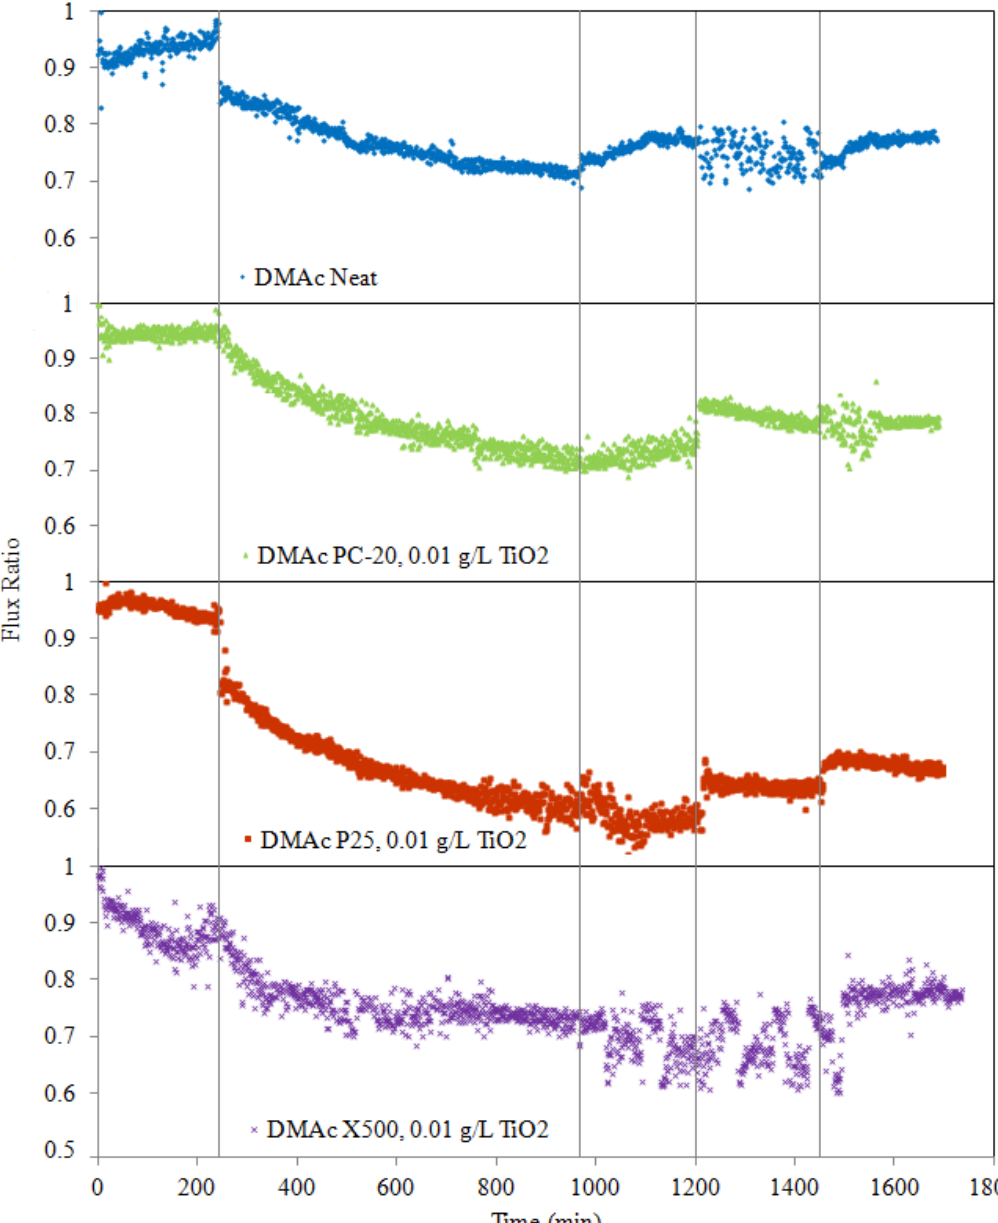
Figure 6. Effect of TiO 2 type on PVDF/TiO 2 MMM anti-fouling potential during five stages: pure water flux for 4 h, HA solution filtration for 12 h, hydraulic cleaning pure water flux for 4 h, water flux for 4 h after 3 h of UV irradiation, and water flux for 4 h after a 2 nd round of 3 h of UV irradiation. Operation conditions during the experiment: [HA] = 2 mg/L; [Ca 2+ ] = 1 mM (as CaCl 2 ); pH 7.0; temperature = 25 ± 1 °C; cross-flow velocity = 4.0 L/hr, operating pressure = 0.5 bar; light intensity = 1.53 mW/cm 2 .